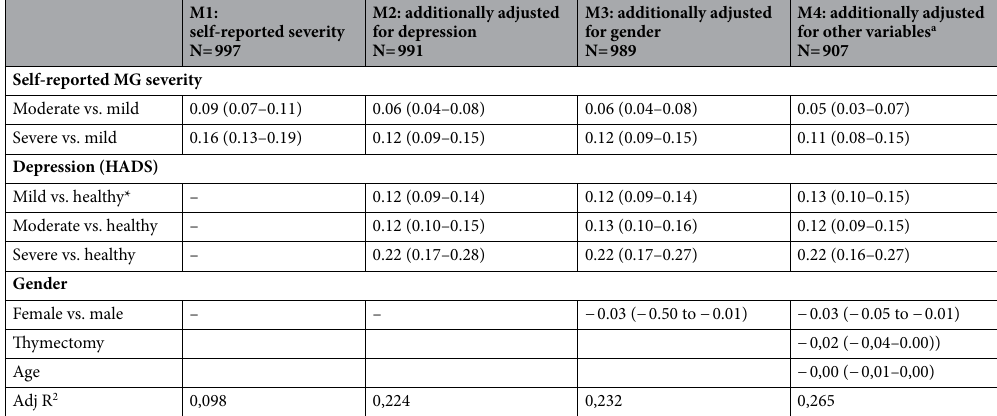
Table 4. Associations between self-reported MG severity and BSFC scale scores (log-transformed continuous outcome). Stepwise linear regression analysis. Estimated marginal means with 95%CI for log-transformed BSFC scale scores. *healthy = no depression according to HADS. a M4: Additionally adjusted for thymectomy,